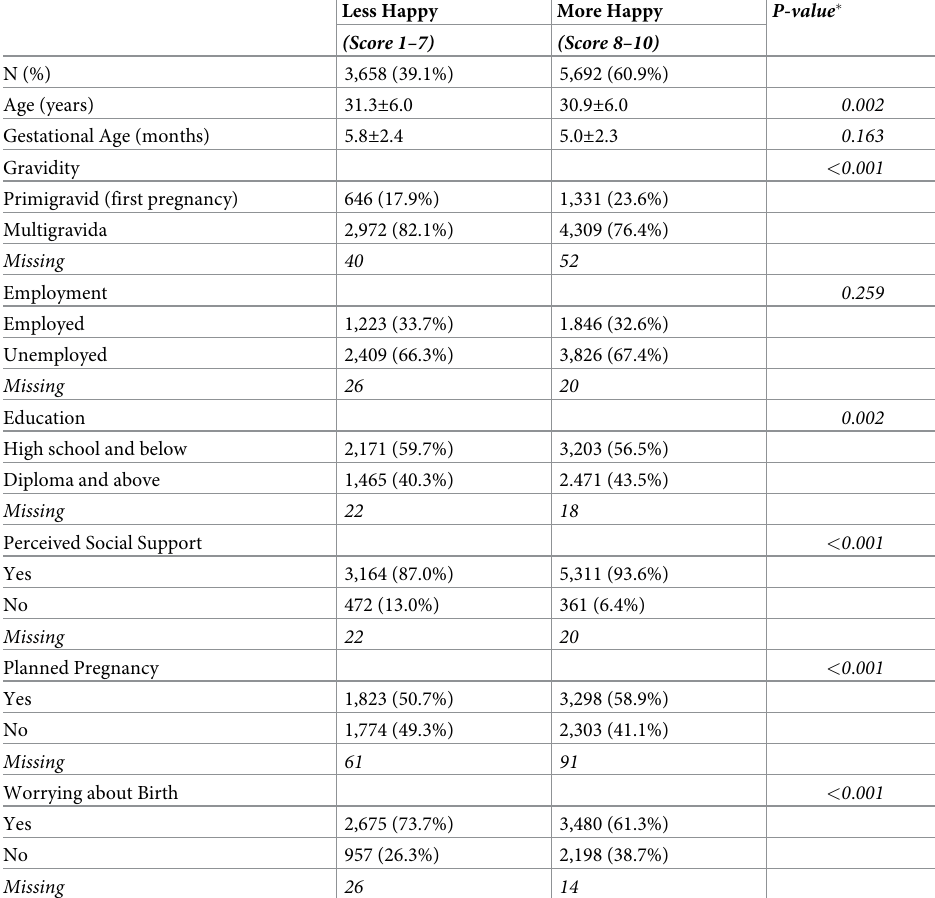
Table 1. Characteristics of 9,350 pregnant women according to self-reported happiness score in Al Ain, UAE. The Mutaba’ah